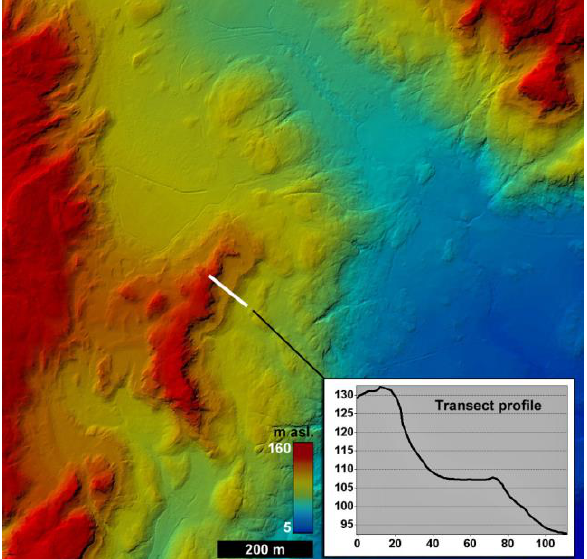
Figure 10: Shoreline morphology. Shaded relief LiDAR image showing the Main Line as a marked discontinuous terrace carved into bedrock (Høgaas, Sveian 2015).